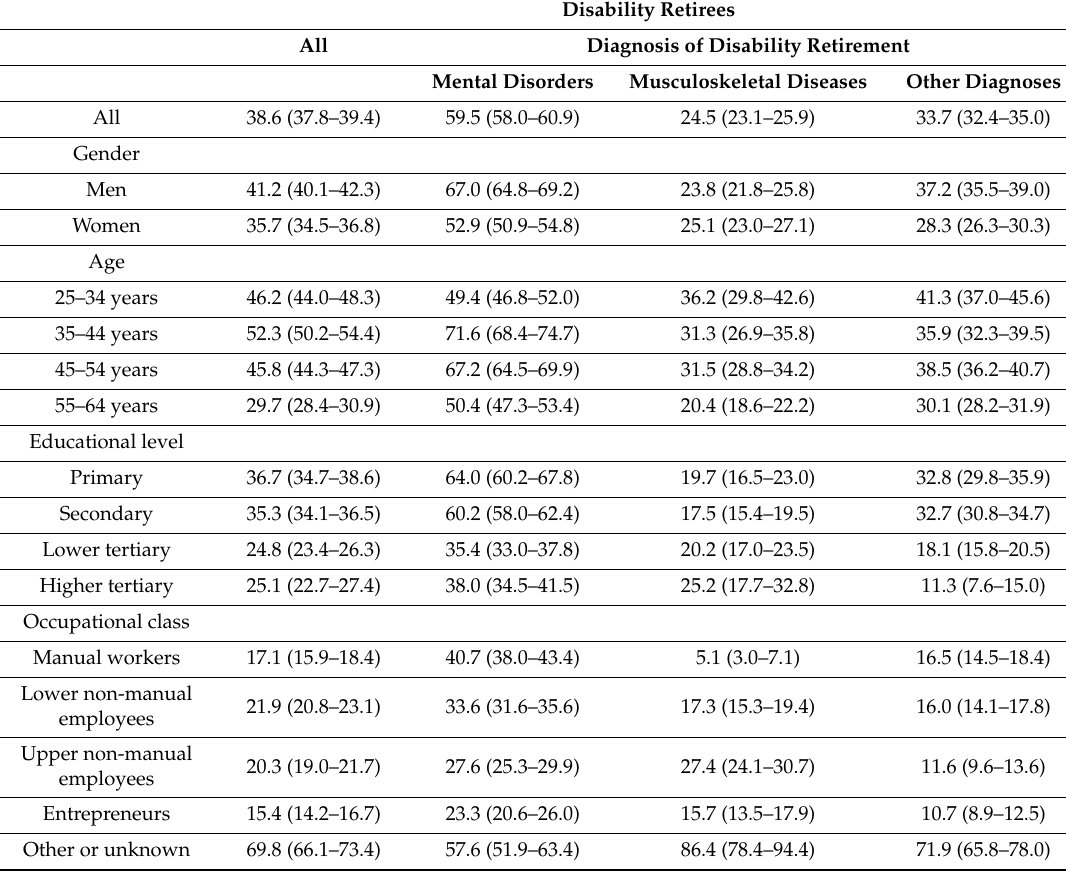
Table 3. Excess number of unemployment days among cases compared to the controls during the years preceding disability retirement by the study variables, mean with 95% confidence intervals adjusted for gender, age and calendar year. The last year before disability retirement